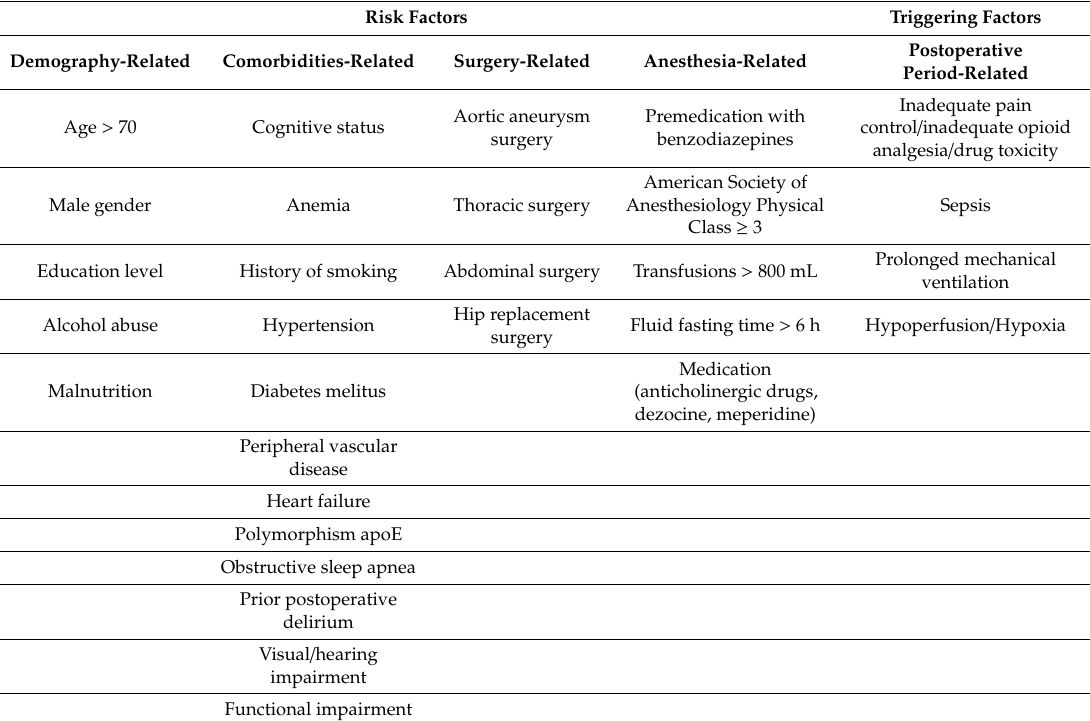
Table 3. Predisposing and triggering factors of delirium [23–25].